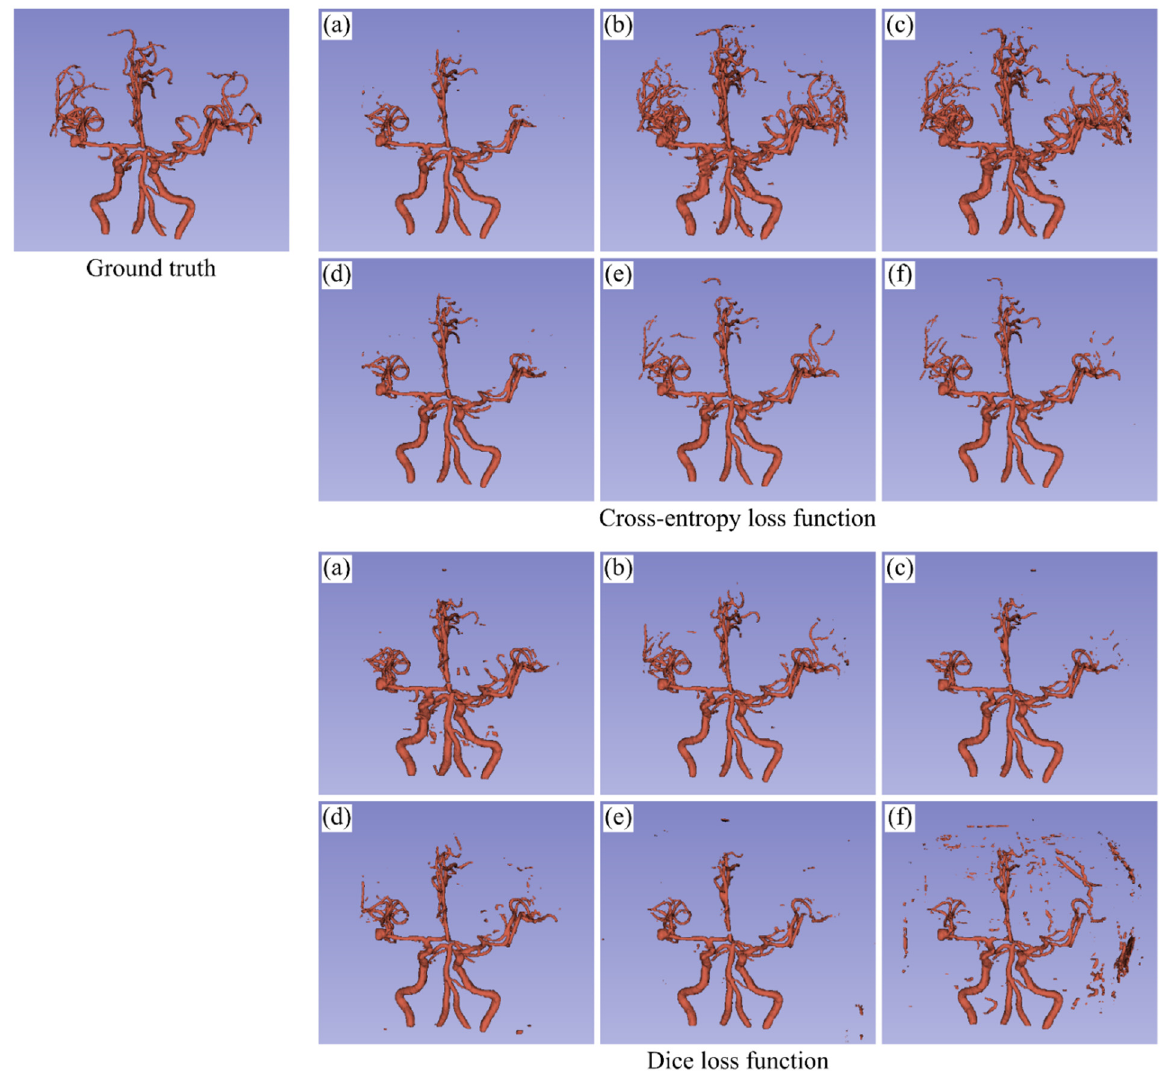
Figure 5. Visualization of the segmentation results of blood vessels in the binary-class segmentation task. ( a ) No weighting, ( b ) Inverse frequency weighting, ( c ) Inverse median frequency weighting, ( d ) Focal weighting, ( e ) Distance transform map-based weighting, and ( f ) Distance penalty term-based weighting.